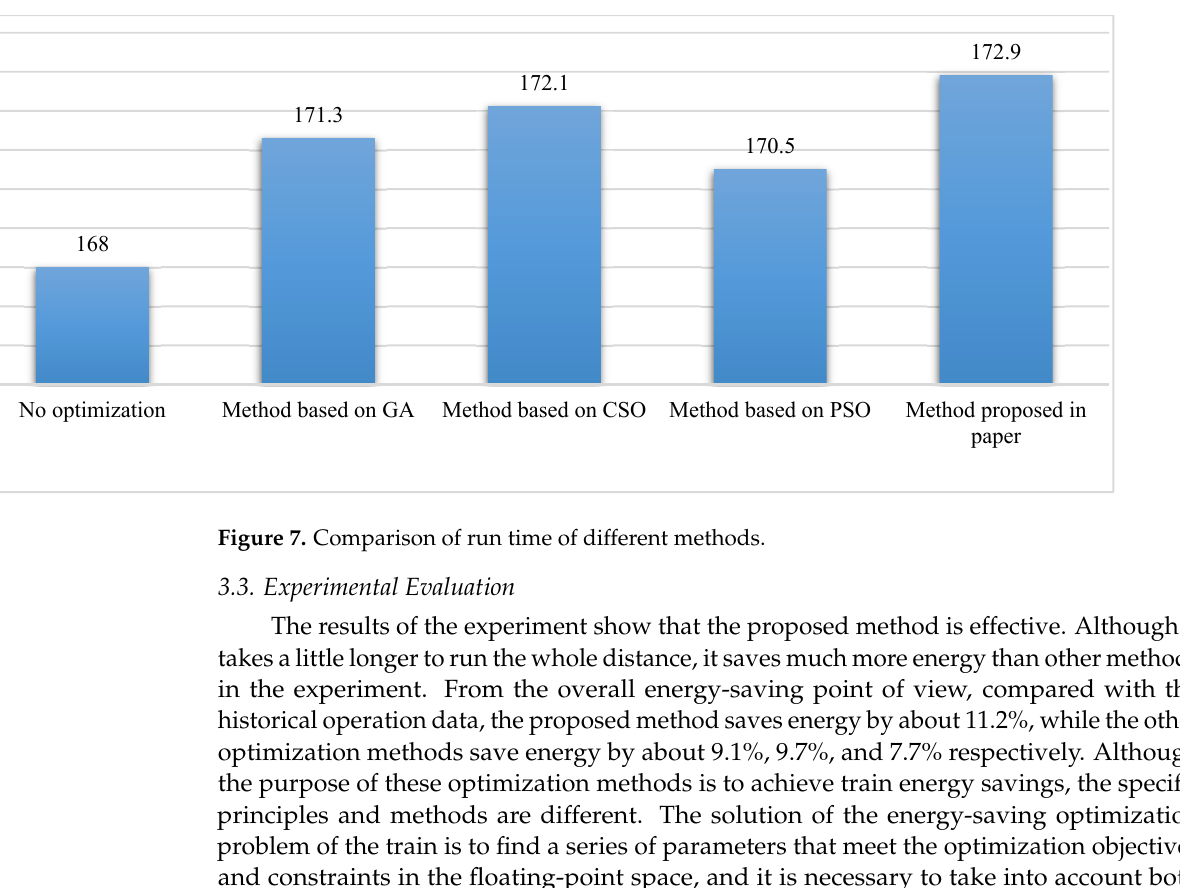
Figure 6. Comparison of energy consumption of different methods.